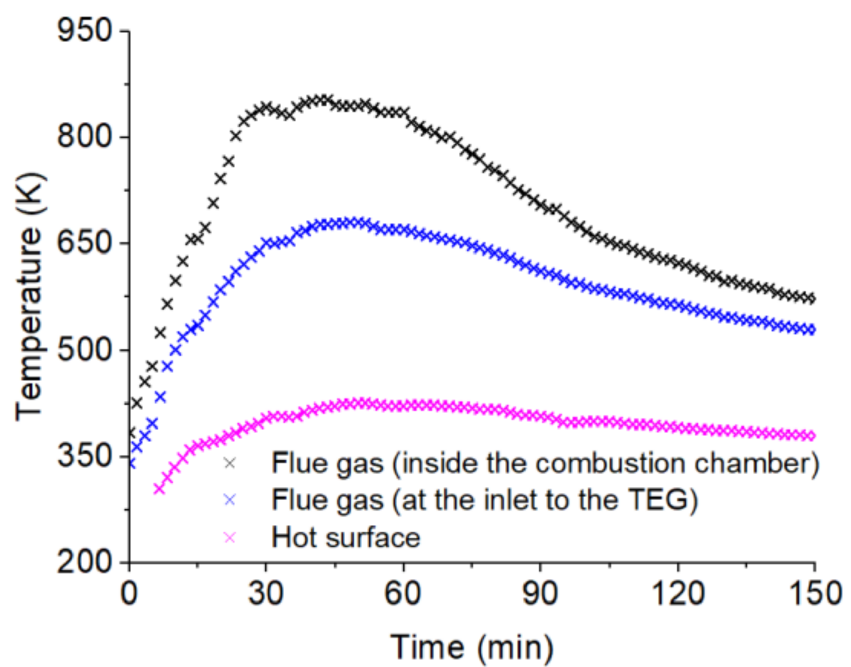
Figure 10. Variations in the temperature of the flue gas at the selected points of the tested